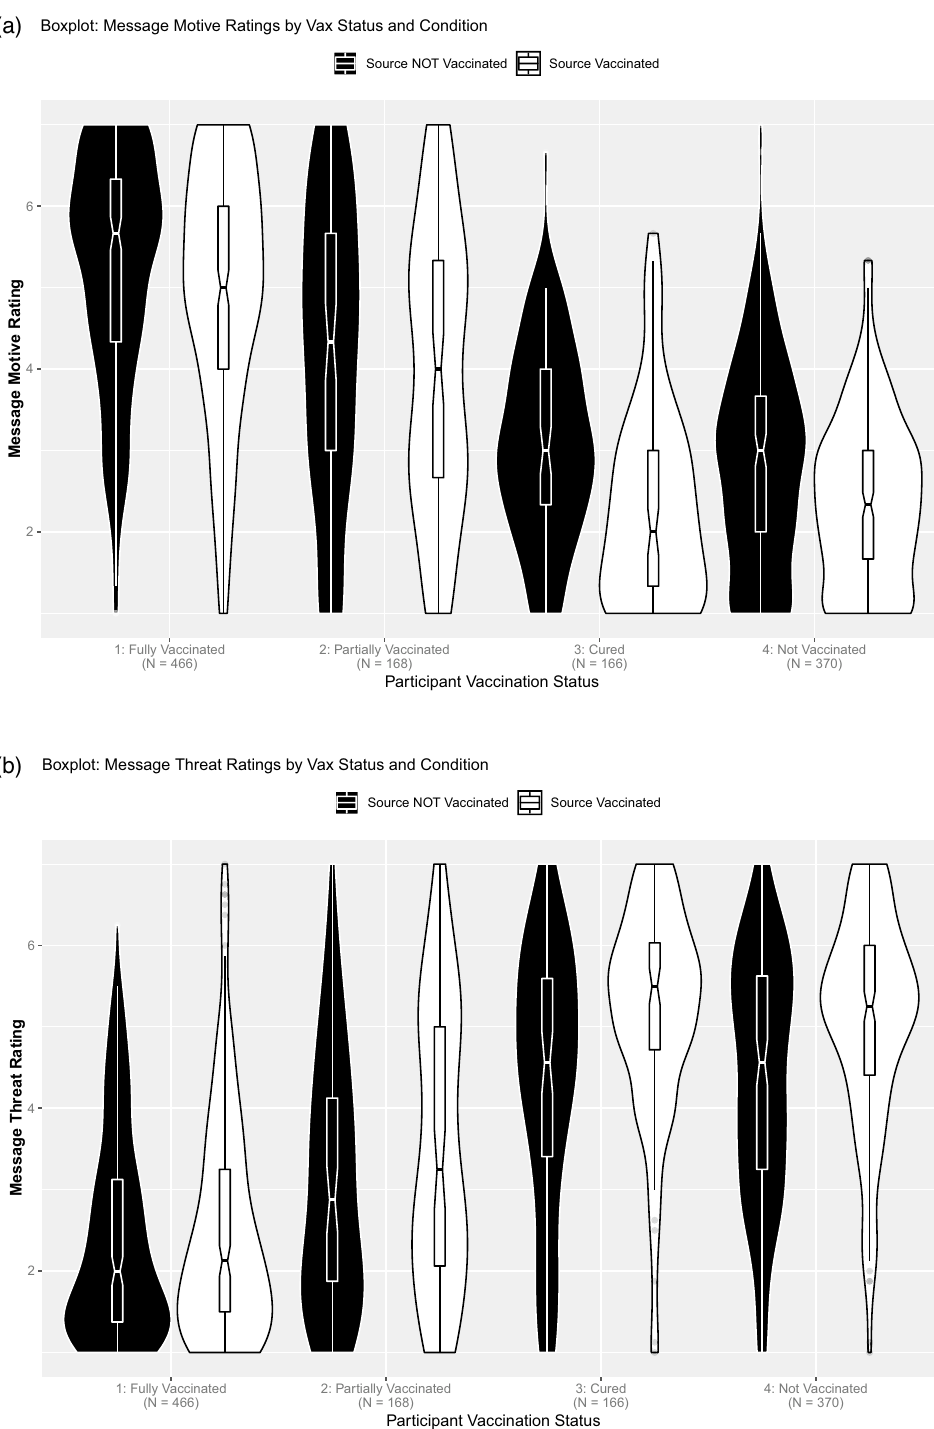
Figure 2. Boxplots with violin-plots ( a ) Message motive rating by message source (unvaccinated vs. vaccinated) and participant vaccination status. ( b ) Message threat by message source (unvaccinated source vs. vaccinated) and participant vaccination status. ( c ) Message source rating by message source (unvaccinated source vs. vaccinated) and participant vaccination status. ( d ) Word count of free text response by message source (unvaccinated source vs. vaccinated) and participant vaccination status. Eight extreme datapoints > 300 words were omitted for plotting. Note. Boxplot notches indicate 95%